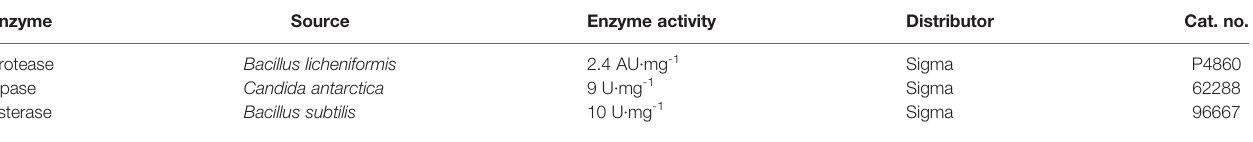
TABLE 1 | Speci fi cations of enzymes used in this study. Enzyme Source Enzyme activity Cat.